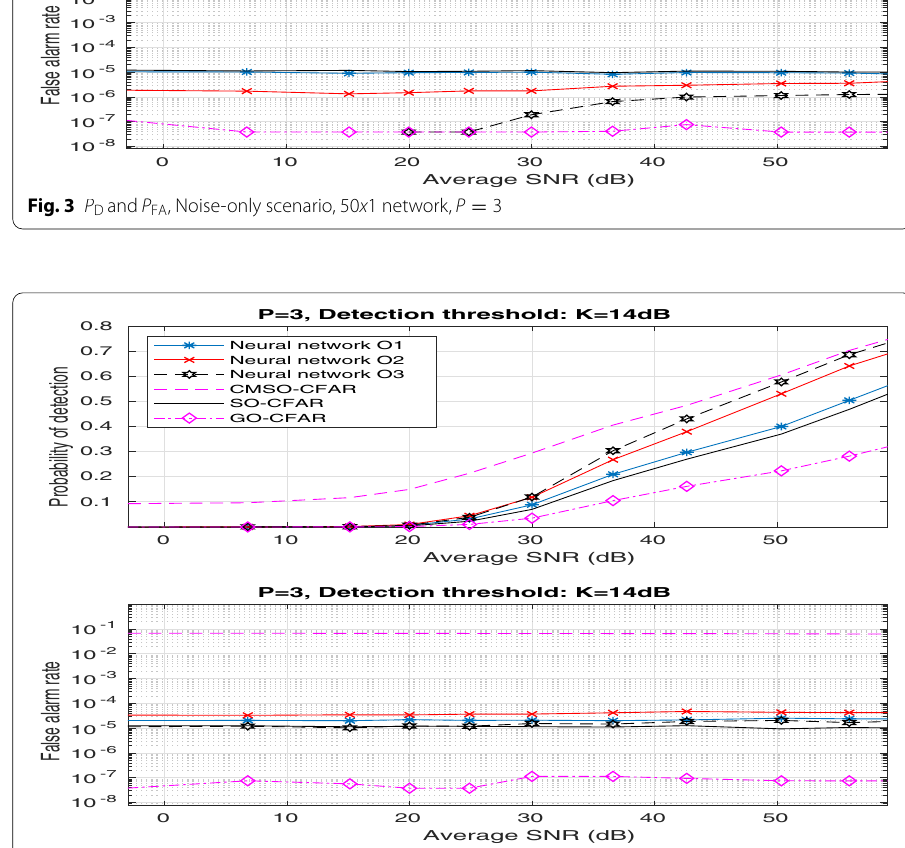
Fig. 4 P D and P FA , Noise-only scenario, 50 x 2 network, P =